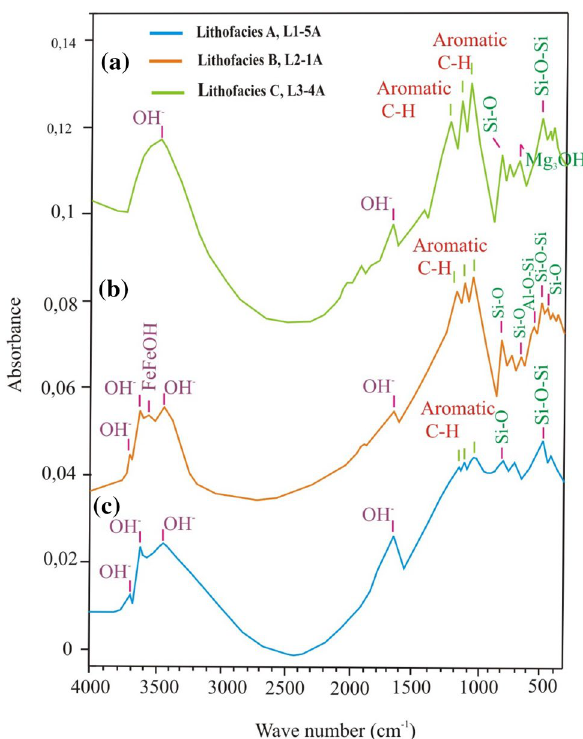
Fig. 11 The FTIR spectra of (a) Lithofacies C section 4A sample (b)